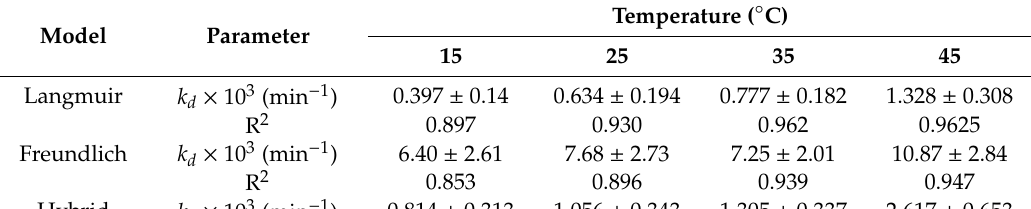
Table 5. Optimal estimates and 95% confidence intervals of the parameters of three kinetic models for MB sorption onto BP.